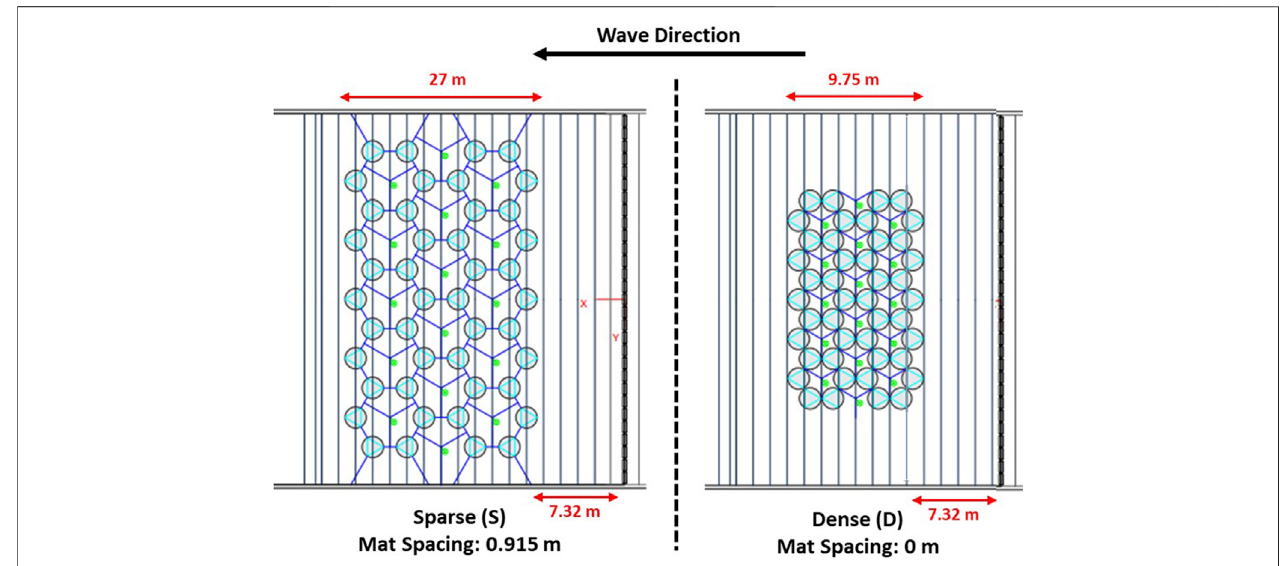
FIGURE 5 | Aerial view sketches of the two mat network con fi gurations (Sparse, left, and Dense, right) inside the basin. The vertical lines represent divots in the bottom of the basin where eyelets (light green) were placed as anchor points. The spacing between these lines is 1.22 m. The wavemaker is to the right, the beach is to the left. The dark blue lines are interconnections between the mats (circles), with the light blue lines within the circles indicating the webbing sewn into the canvas.